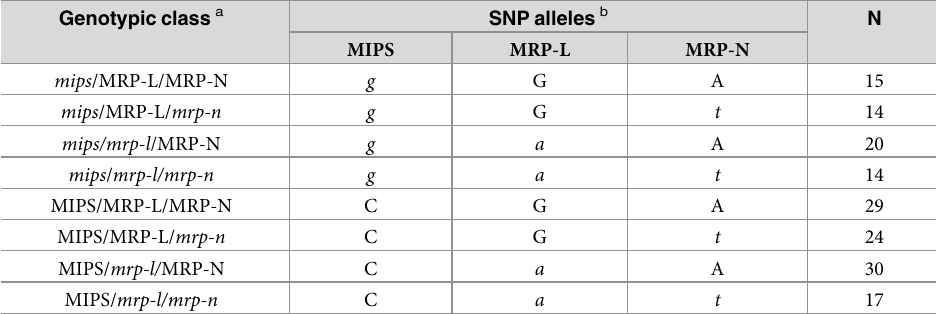
Table 1. Genotypic classes of the homozygous RILs of V99-5089 x CX-1834 population. Genotypic class